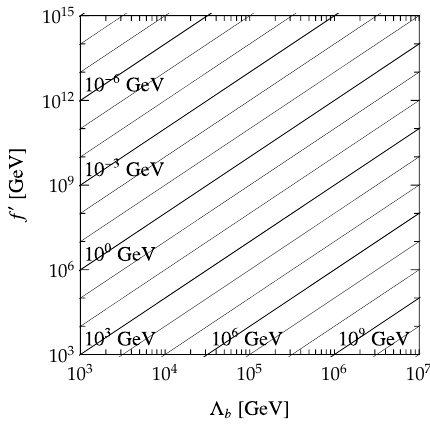
Figure 11 . Contours of m (cid:30) in the f 0 {(cid:3) b plane. The thick lines correspond to the indicated